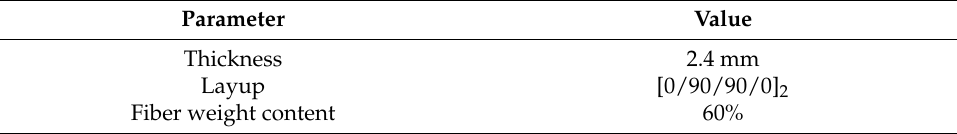
Table 1. GF/PP laminate parameters.